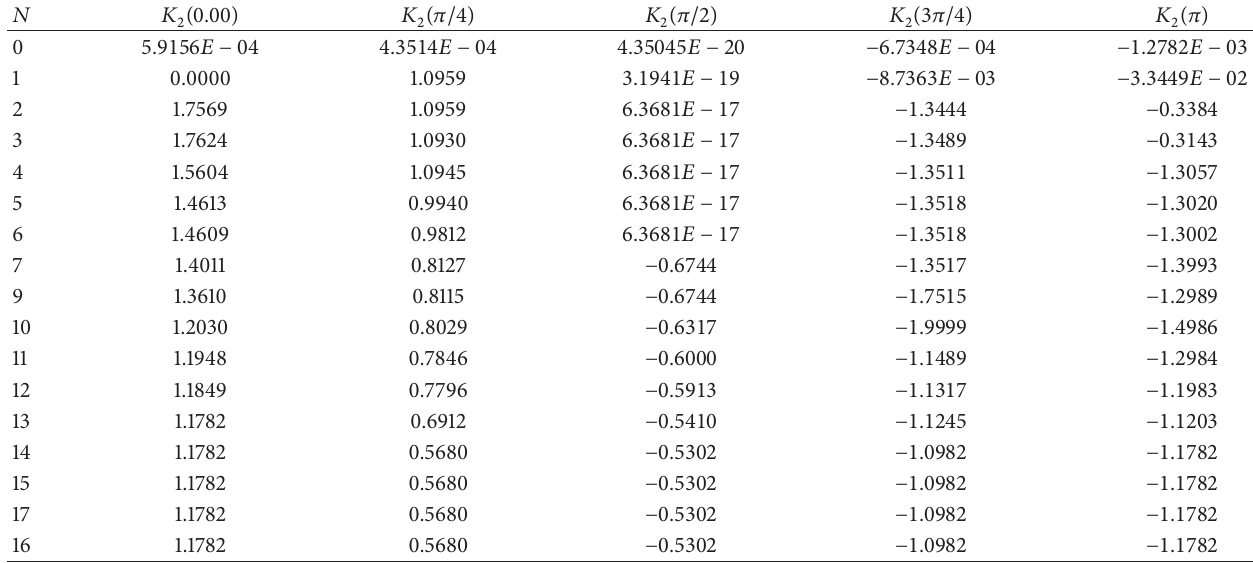
Table 2: Numerical convergence for the sliding mode stress intensity factor, 𝐾 2 (𝜙) , for 𝑚 = 1 when 𝑐 = 0.45 .